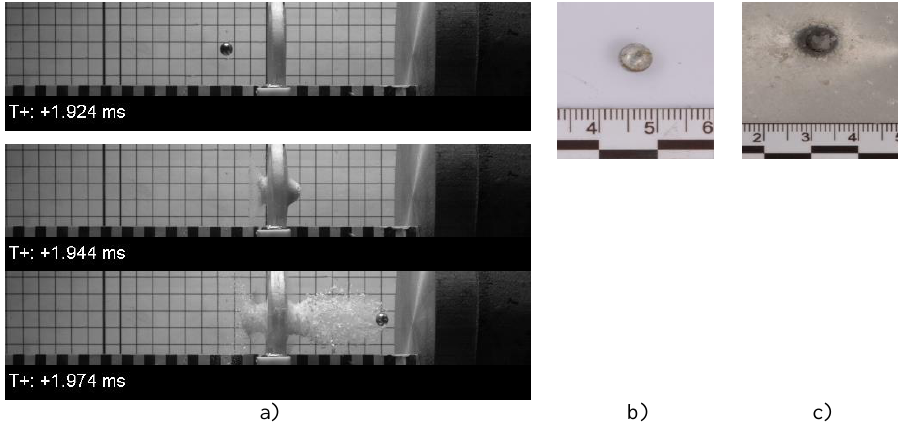
Fig 4. The photographic record of the plexiglass penetration ( a ), the drummer ( b ) and the front layer of the barrier-“witness” ( c ) after the collision at V 0 = 1595